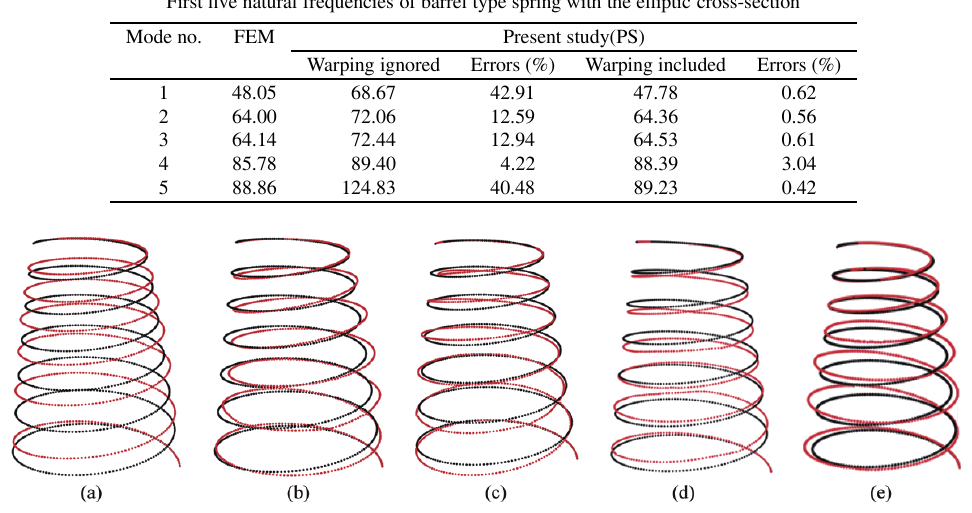
Fig. 3. First fi ve mode shapes of the free vibrating conical type spring with the elliptic cross-section: (a) First mode (b) Second mode (c) Third mode (d) Fourth mode (e) Fifth